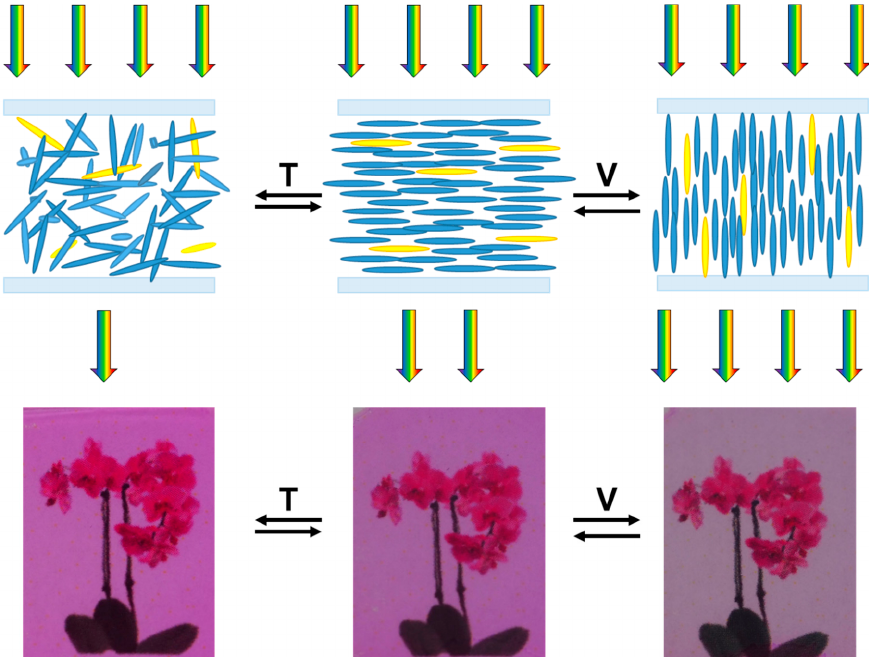
Figure 2. Schematic ( top row ) and photographs ( bottom row ) of liquid crystal and dye alignments in the initial planar state ( middle column ) and its changes upon the application of an electrical field ( right column ) or increased temperature ( left column ). The relative absorption characteristics are indicated by the rainbow-colored arrows.